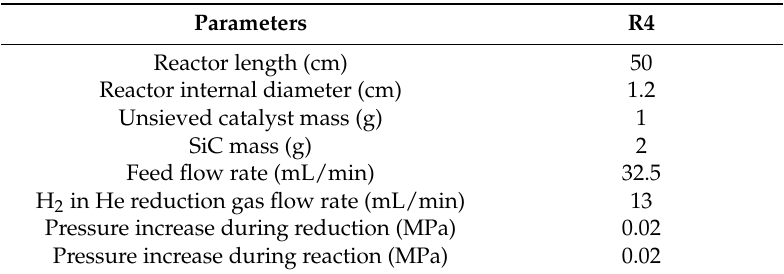
Table 3. Testing parameters for R4.